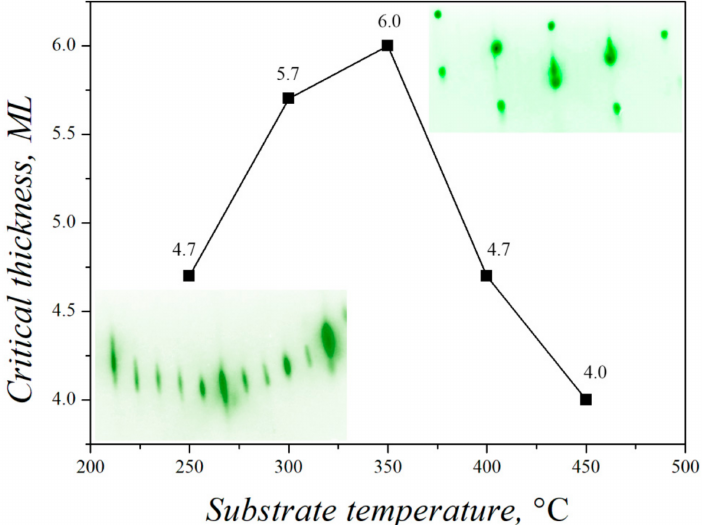
Figure 8. Temperature dependence of the critical thickness on transition from 2D to 3D growth for Ge growth on Si(111).